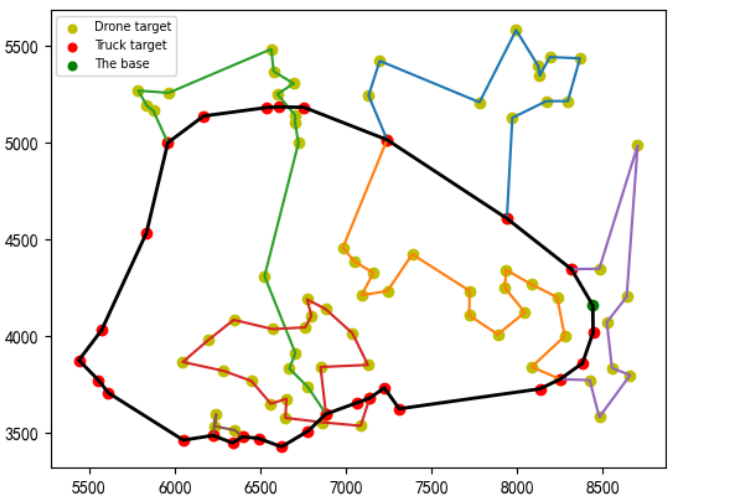
Figure 9. The surveillance route of truck and